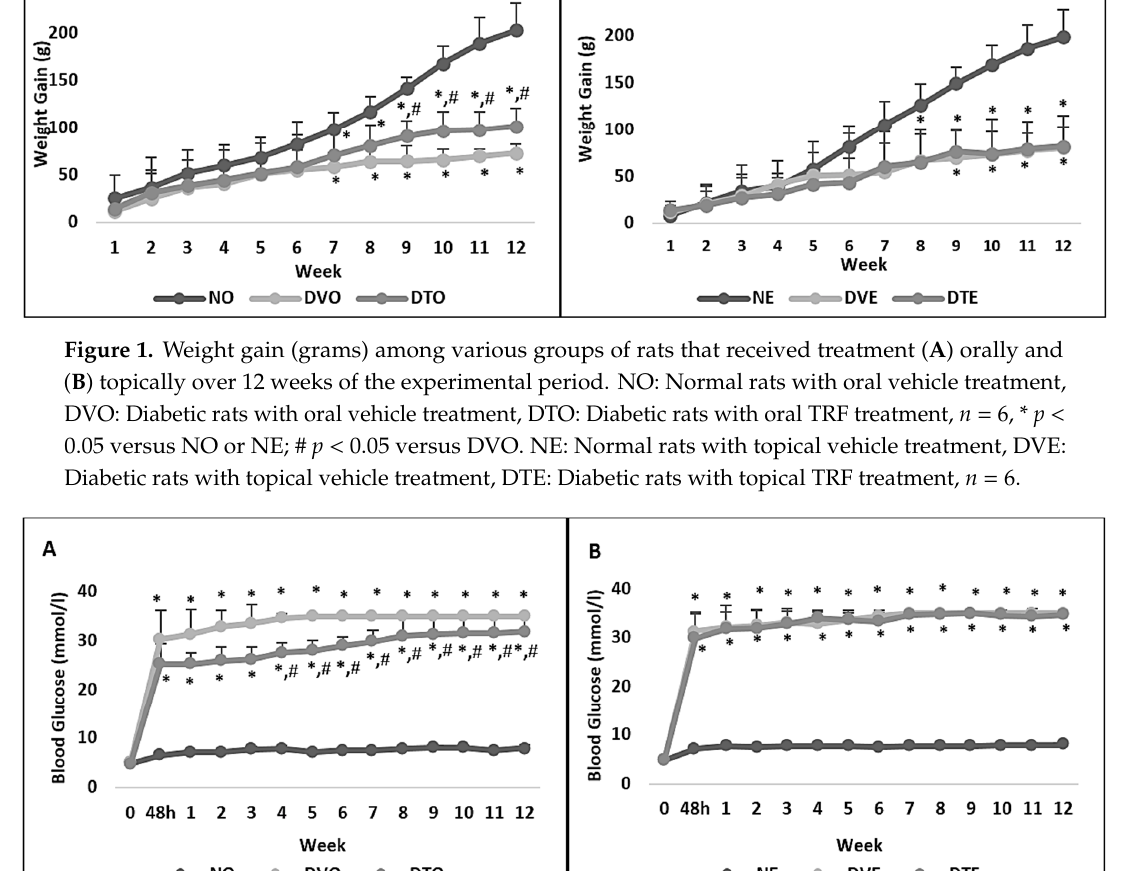
Figure 1. Weight gain (grams) among various groups of rats that received treatment ( A ) orally and ( B ) topically over 12 weeks of the experimental period. NO: Normal rats with oral vehicle treatment, DVO: Diabetic rats with oral vehicle treatment, DTO: Diabetic rats with oral TRF treatment, n = 6, * p < 0.05 versus NO or NE; # p < 0.05 versus DVO. NE: Normal rats with topical vehicle treatment, DVE: Diabetic rats with topical vehicle treatment, DTE: Diabetic rats with topical TRF treatment, n = 6.